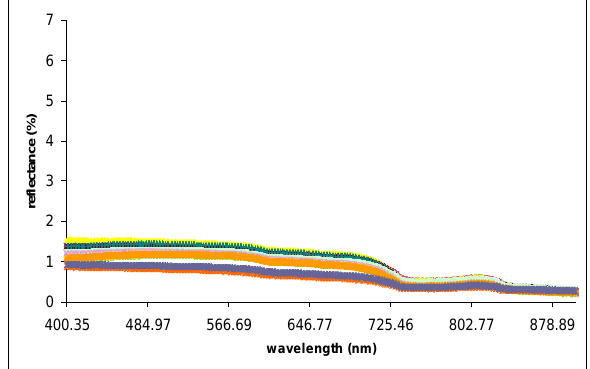
Figure 7: Spectral reflectance from the water tank with black panel at varying depths. The depth ranged from 0 cm and 30 cm above the black panel deployed at the bottom of the tank; the line for the highest reflectance is at 0 cm and the reflectance continuously decreases with water depth increases.